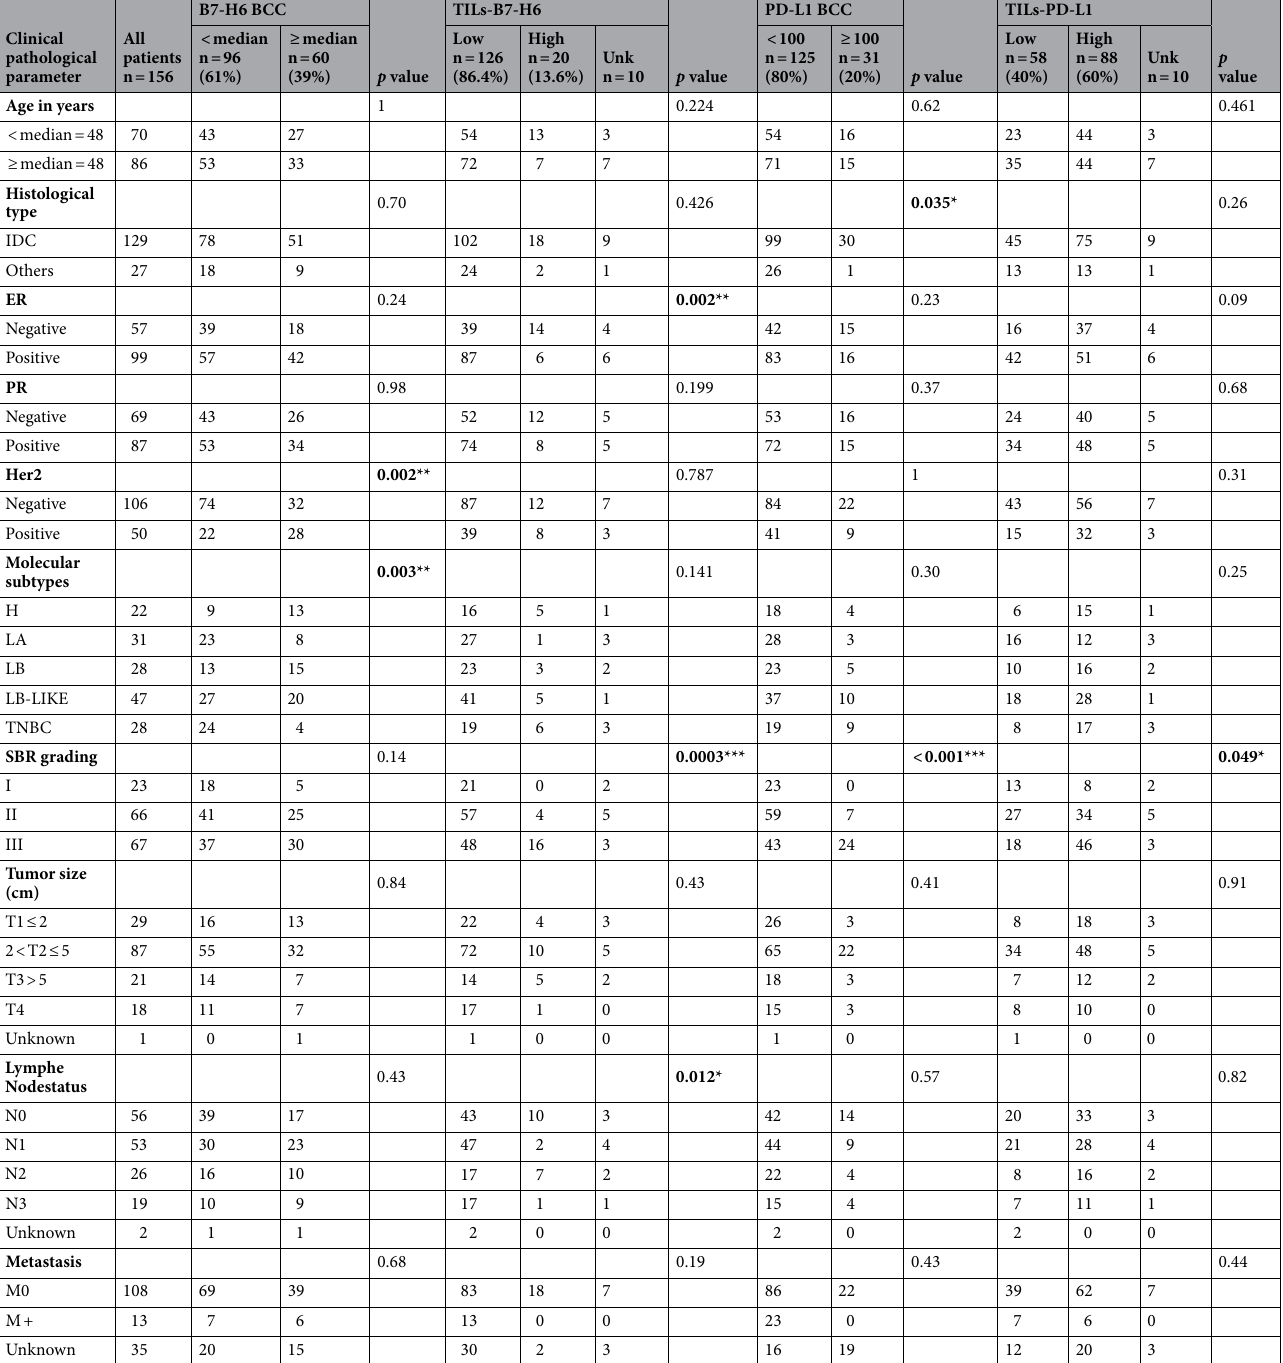
Table 1. Associations of B7-H6 and PD-L1 expression with clinical parameters in primary breast cancer patients. Variable between groups presented in frequency tables evaluated by Chi-Square test. Two sided p values are considered statistically significant if < 0.05 and are indicated in